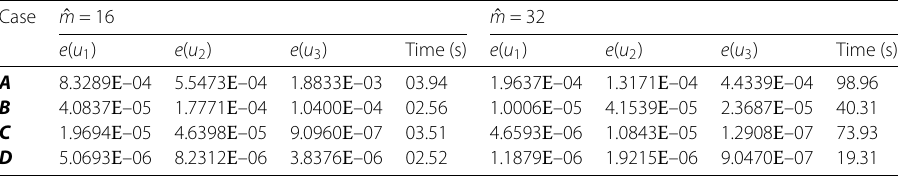
Table 2 The maximum absolute errors and the run time in Example 3